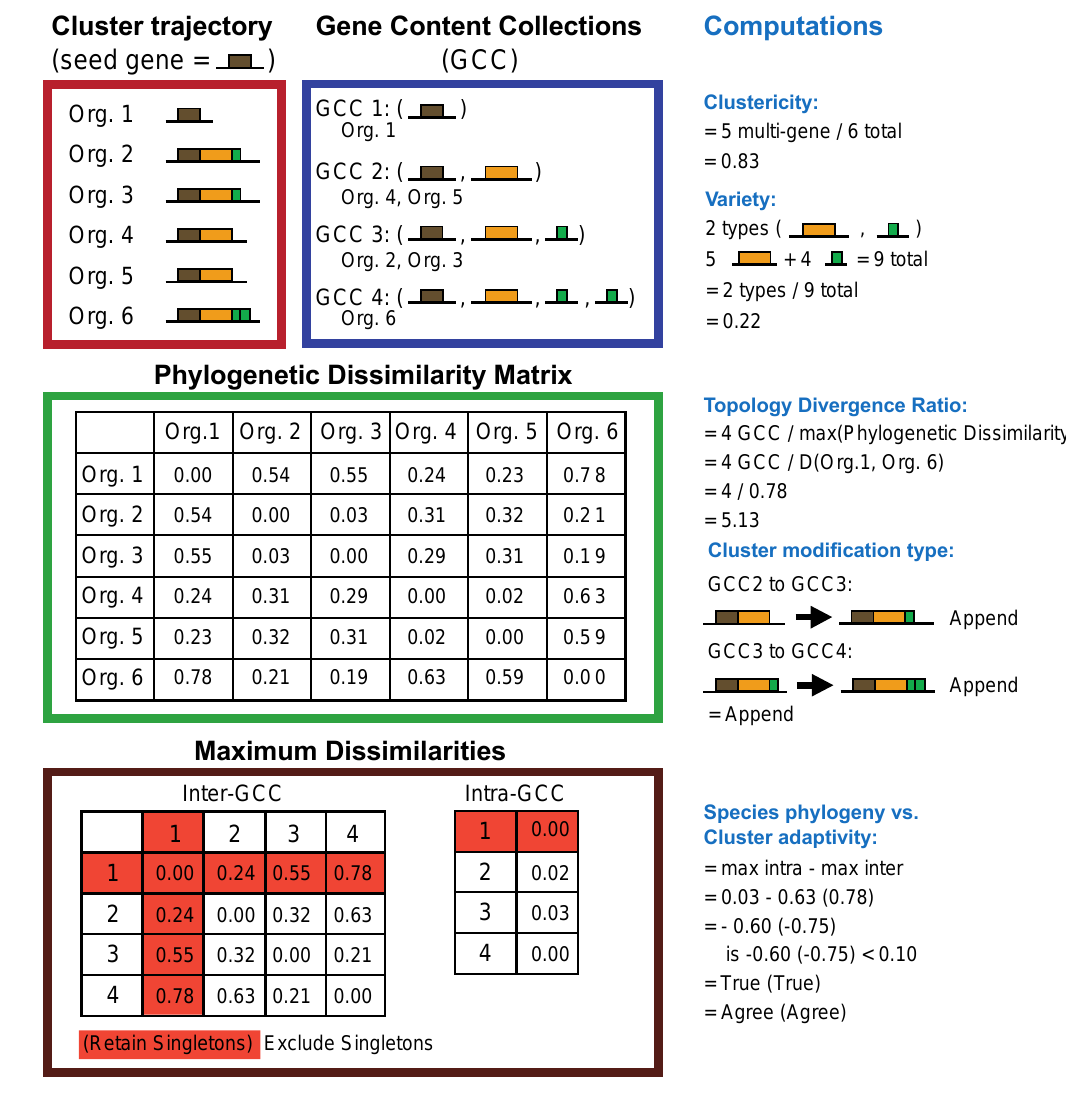
Figure 2. Visualization of Context Trajectory Computations. Computations applied to context trajectories are exemplified in a theoretical context trajectory: OLSs are found in six organisms described as Orgs 1–6, and contain between one and four genes (red box). This trajectory contains four gene content collections (blue box), and clustericity and variety scores of 0.83 and 0.22 (top right), respectively. Based on a theoretical matrix of species-level phylogenetic dissimilarities (green box), this trajectory has a topology divergence ratio of 5.13 (middle right). Evaluation of the gene content collections in this trajectory indicate that this context trajectory exhibits an OLS modification type of “Append” (middle right). A comparison of the dissimilarities between organisms found both within and outside of the gene content collections (brown box) enables a comparison of species phylogeny and OLS adaptivity (bottom right), which is evaluated both retaining and excluding singleton genes (red highlighter, brown box). In this example, the species-level phylogeny is consistent with differences in OLS topology between species whether or not singleton genes are excluded.